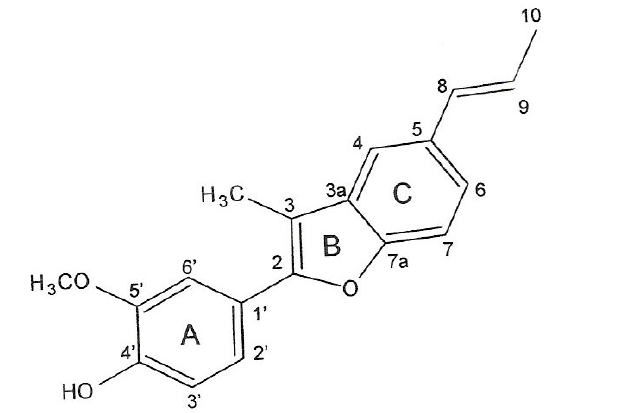
Figure 1. Pure compound eupomatenoid-5 from Piper